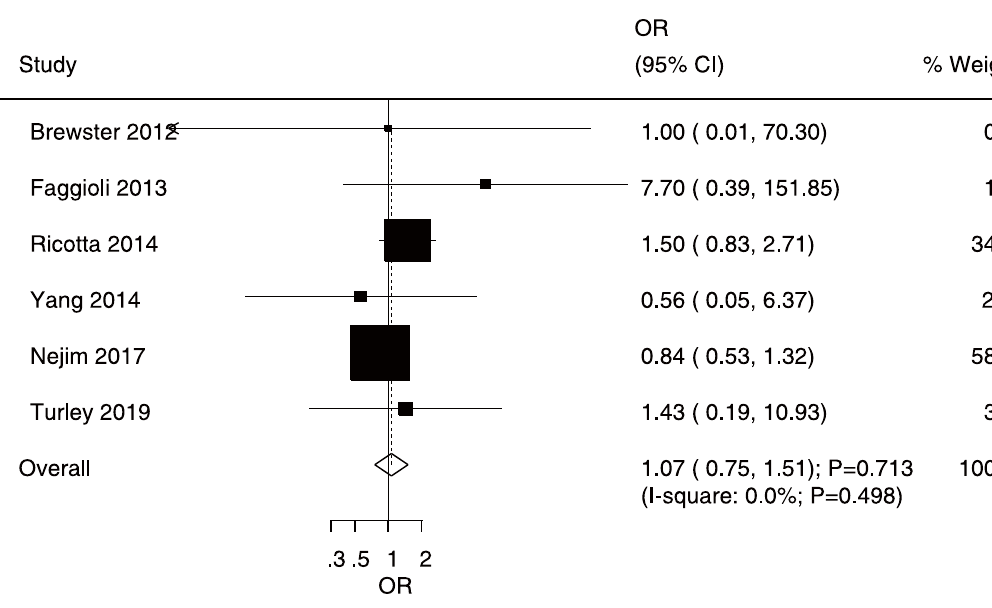
Fig 2. Effects of carotid endarterectomy (CEA) versus Carotid Artery Stenting (CAS) on the risk of stroke.